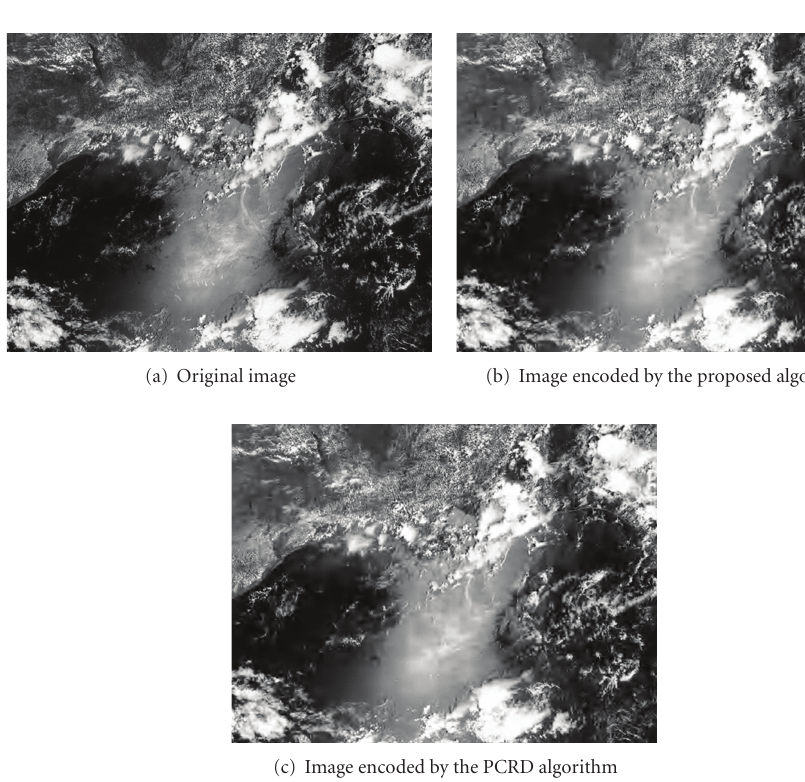
Figure 4: Comparison of the subjective quality of the proposed algorithm and the PCRD algorithm at a bit rate of 0.25 bpp.